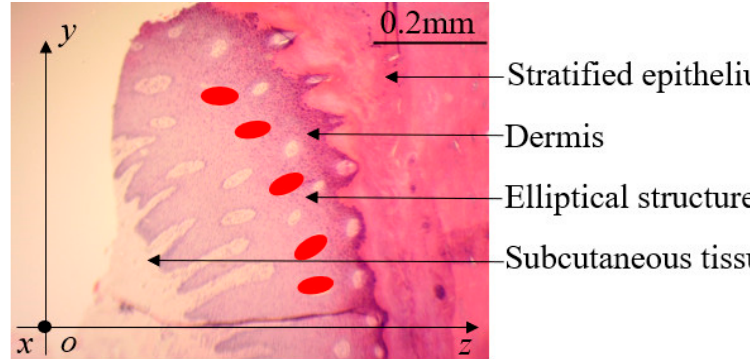
Figure 2. Observation of the tissue structure of the goat hoof